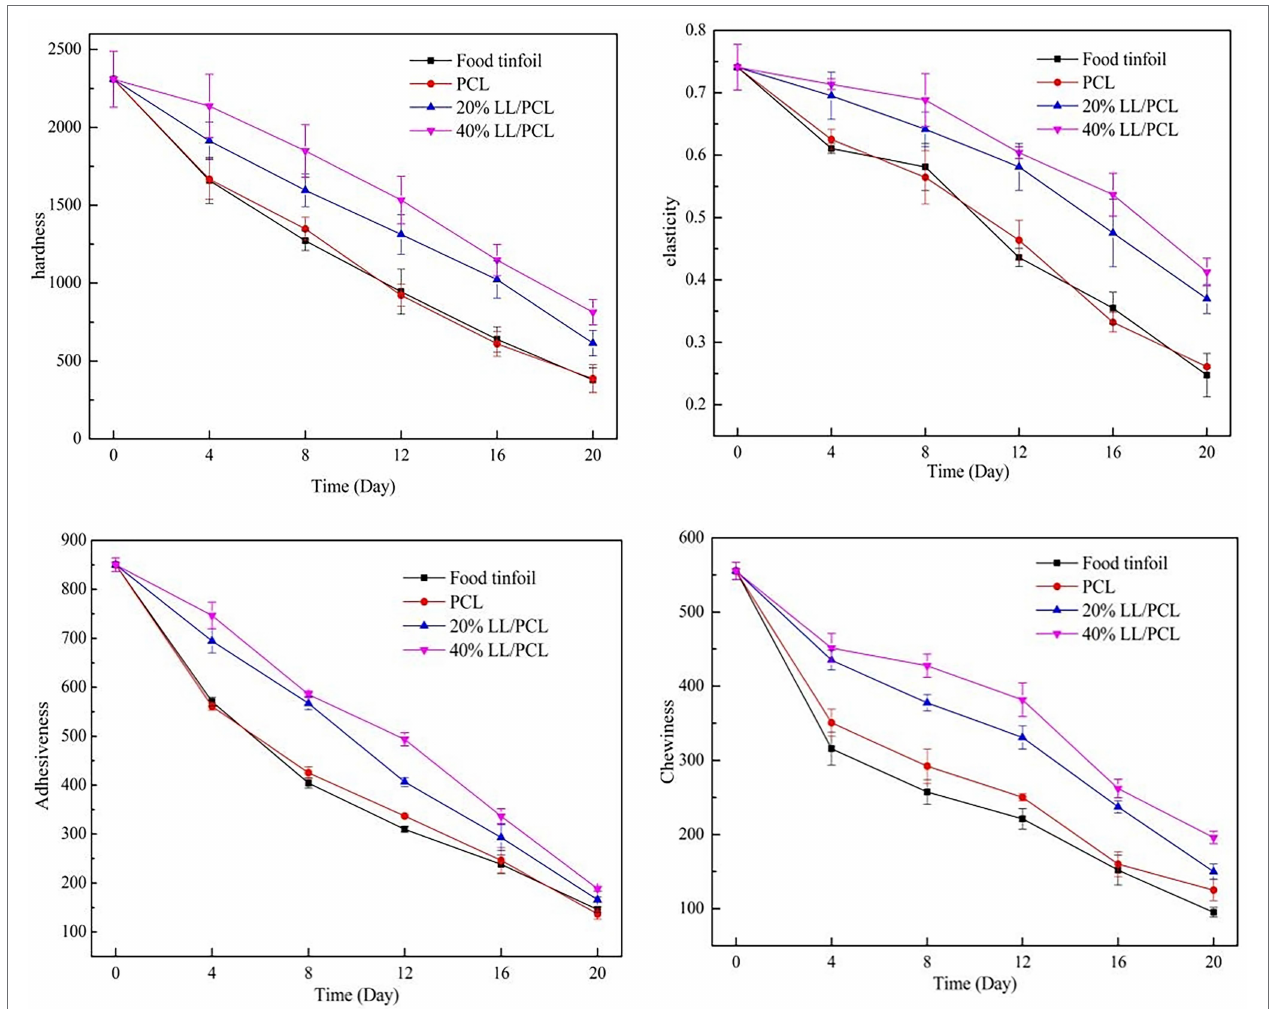
FIGURE 10 | Structural changes of salmon during